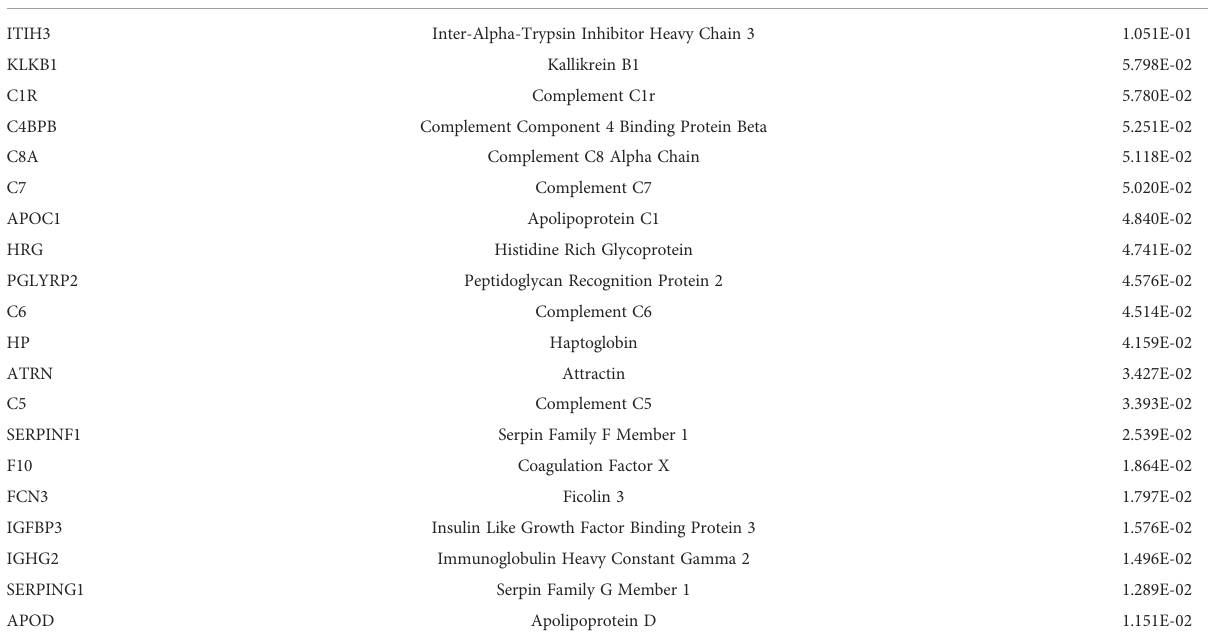
TABLE 4 Proteins distinguishing LD from healthy